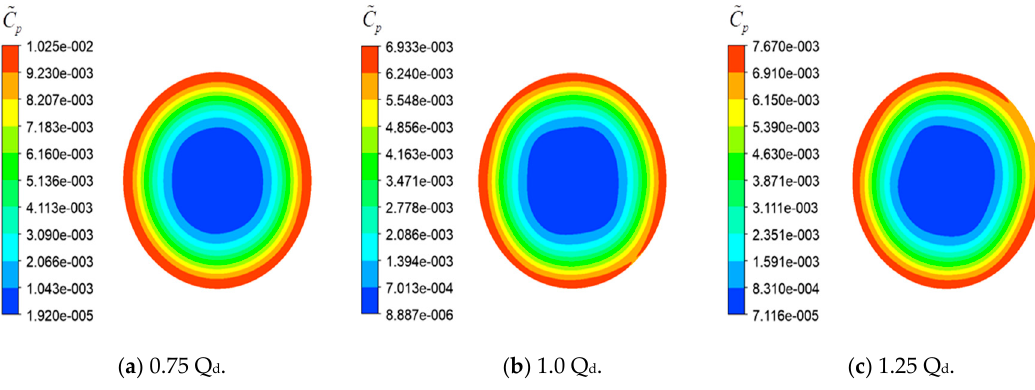
Figure 24. Pressure fluctuation distributions at the outlet of the draft tube.